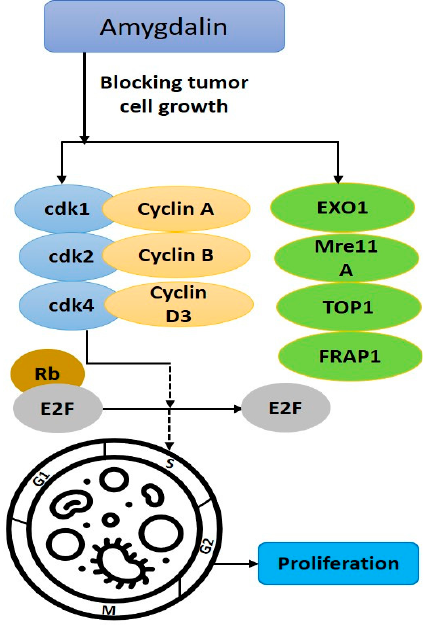
Figure 3. Amygdalin’s anti ‐ tumor effects on cell